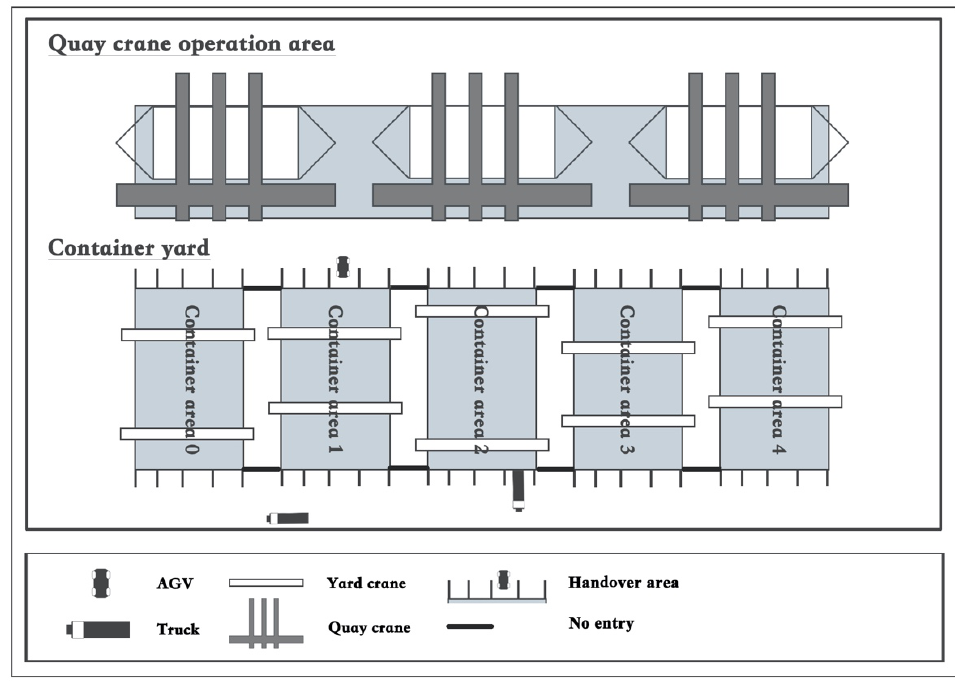
Figure 1. Traditional automated terminal.